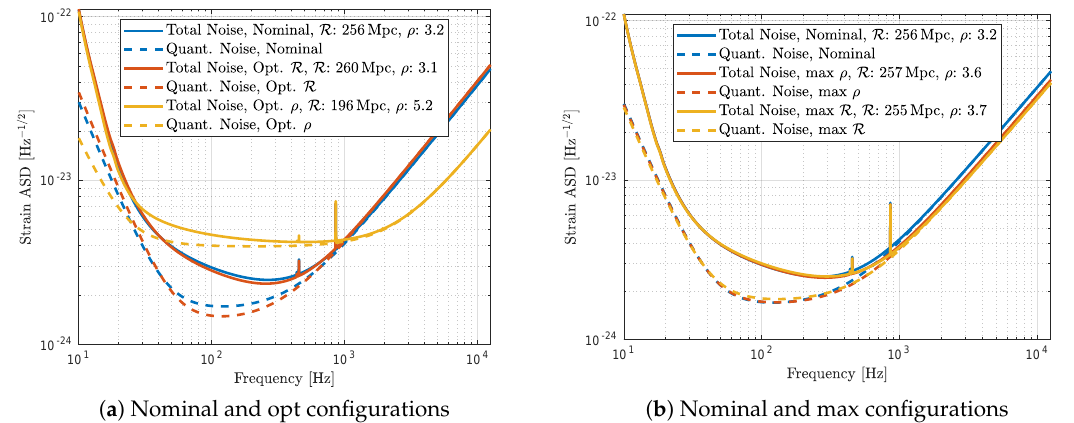
Figure 8. Sensitivity curves for 85ppm RTL optimal and max parameter configurations found for both optimization routines. ‘Opt’ corresponds to an optimal primary parameter, while ‘max’ corresponds to a maximum secondary parameter within a predefined budget of the optimal primary parameter found. Nominal configurations that use the currently expected IM, PRM, and SRM transmittances are shown for